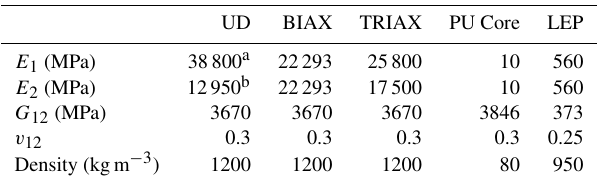
Table 1. Material properties for the thermoplastic and composite materials used in the current